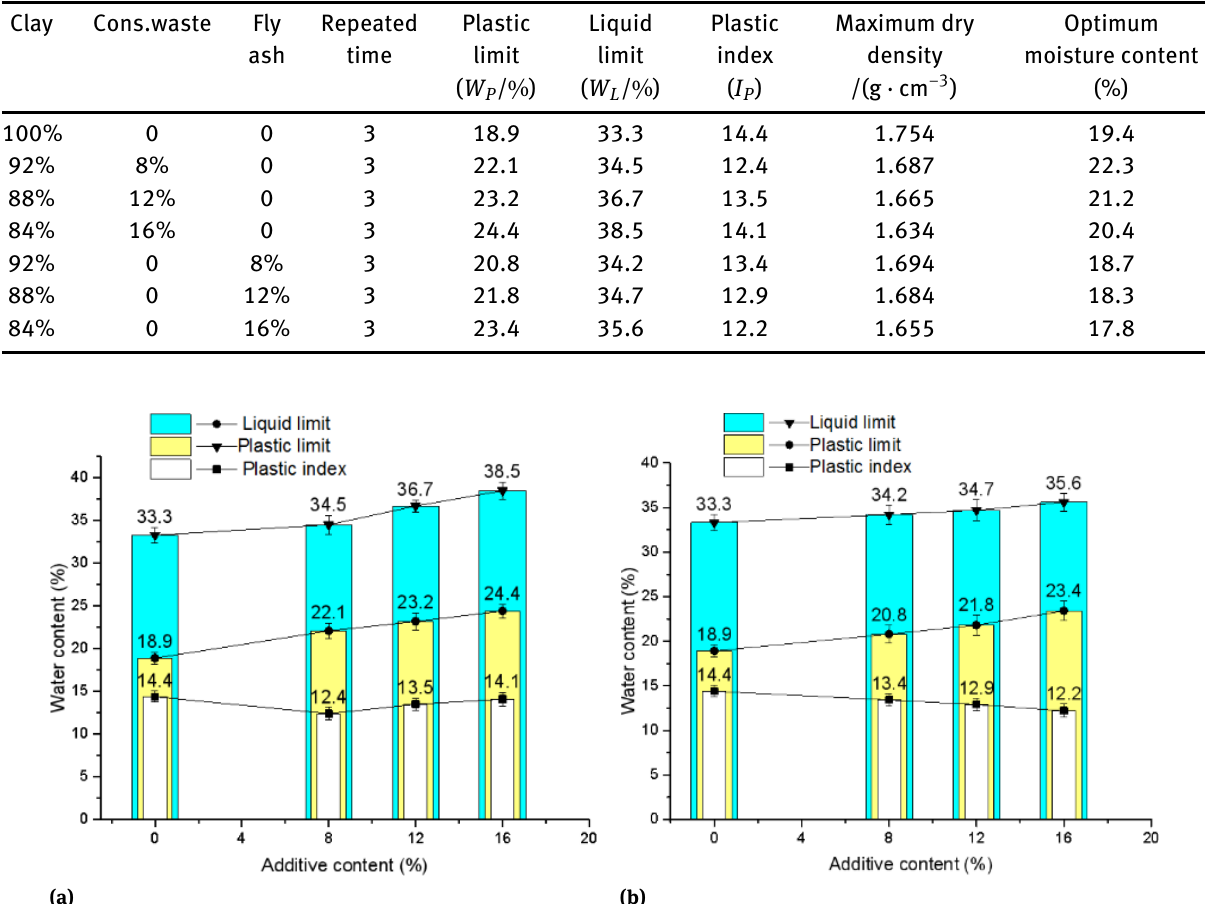
Figure 4: Change of clay consistency indexes under different contents of fine aggregates of construction waste (a), and fly ash